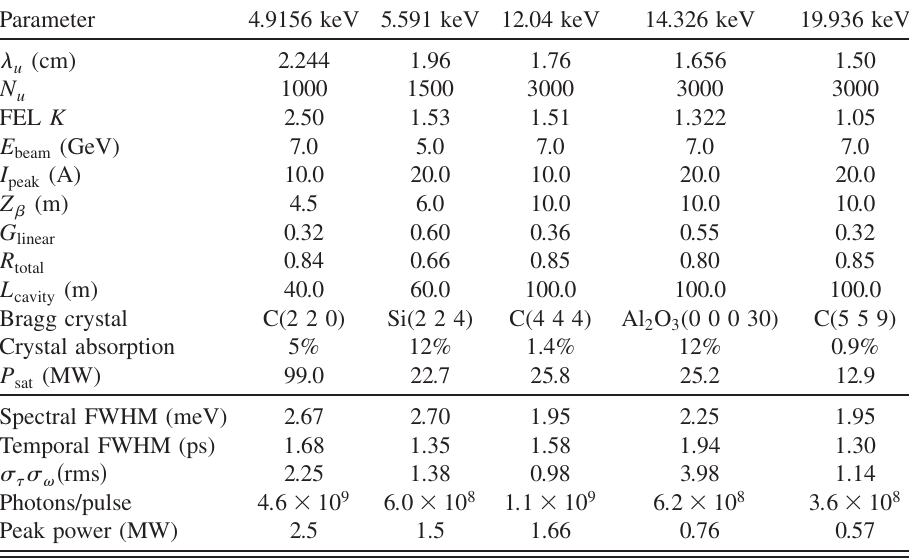
TABLE I. Possible undulator, beam, and optical cavity parameters. For all cases the